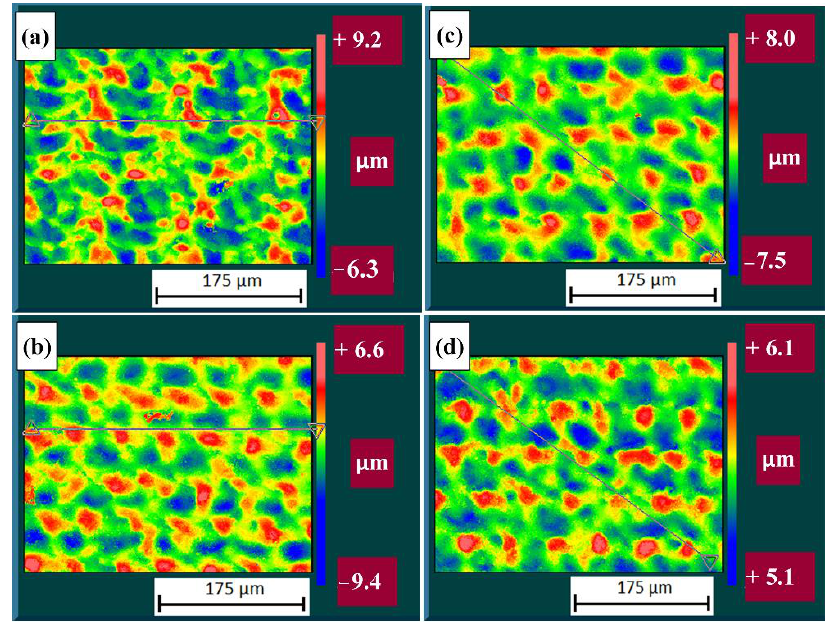
Figure 9. Pseudo-color image of 3D profiles from the profilometer: ( a ) DLC1; ( b ) DLC2; ( c ) DLC3 and ( d ) DLC4.